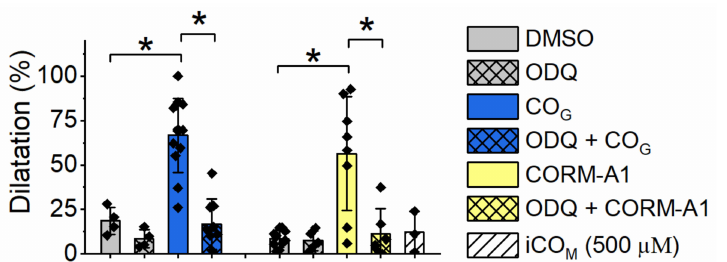
Figure 4. Comparison of the effects of CO delivered by CO-saturated buffer or released by CORM- A1 on vasodilatation in aortic rings. Aortic rings dilatation was evaluated 5 min after addition of CO–saturated assay buffer (CO G ; 60%) or 30 min after addition of CORM-A1 (500 µ M) or iCORM-A1 (500 µ M). Data represent means +/-SD from at least three independent experiments. * p <